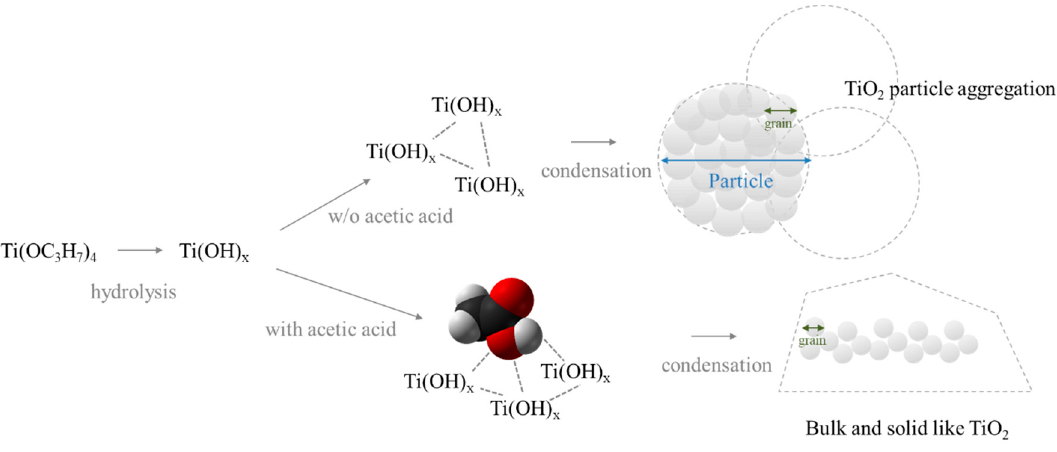
Figure 5. The proposed schematic concept of TiO 2 formation with and without acetic acid.